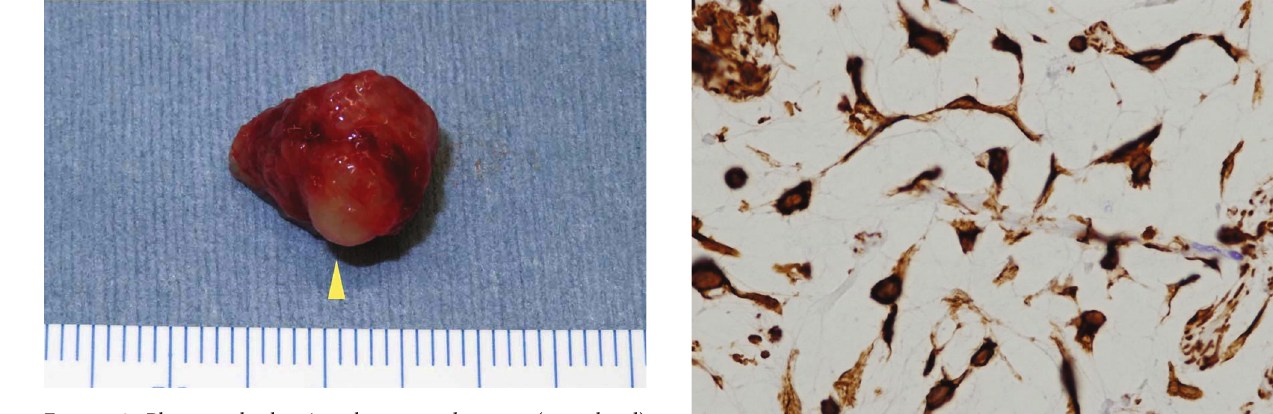
Figure 3: Photograph showing the resected tumor (arrowhead) surrounded by the muscle of the tongue.